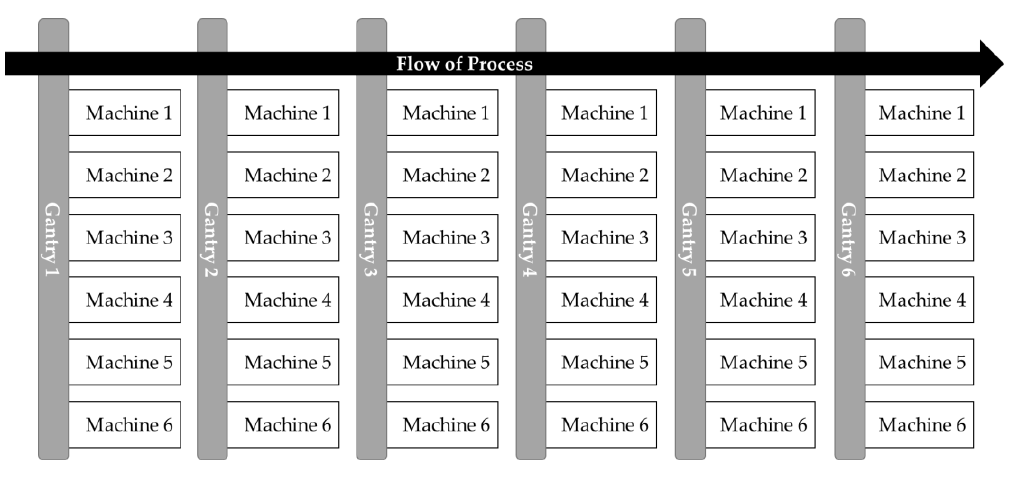
Figure 6. The reconfiguration planning process.